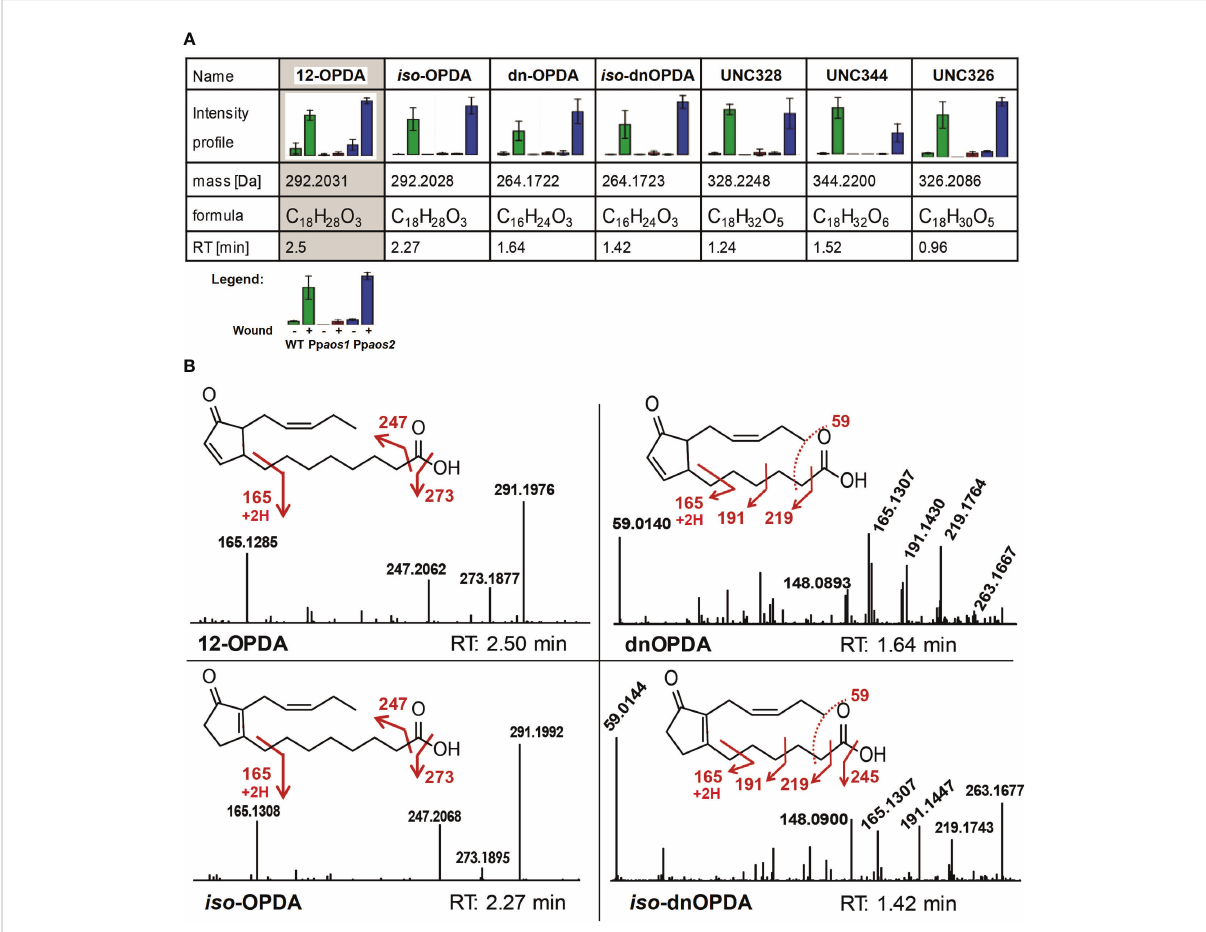
FIGURE 3 Intensity pro fi les and fragmentation patterns of 12-OPDA, dnOPDA and further wound-related oxylipins. (A) Wound-related and AOS-dependent oxylipins. Shown are intensity pro fi le, accurate mass, retention time and the putative chemical composition derived from the accurate mass. Data was acquired using UPLC-ESI-TOF-MS (non-polar phase on a C18-reversed phase column). Of each genotype, 3 parallel cultures and of each culture 2 extractions were analyzed. Metabolic identities of features were determined using m/z, RT and intensity pro fi les assisted by the MarVis toolbox (Kaever et al., 2015). Bar graphs show mean values with standard deviations. Intensity pattern show: Green – P. patens WT, Red – Ppaos1, Blue – Ppaos2 (for each: left – control, right – wounded). (B) Some of the main compounds accumulating after wounding in P. patens . MS/MS fragmentation pattern and chemical structure of OPDA, iso -OPDA, dnOPDA and iso -dnOPDA are shown. Spectra were obtained by UHPLC-ESI-QTOF-MS/MS analysis in the negative ionization mode (collision energy 20 eV). Accurate m/z data can be found in Supplementary Table